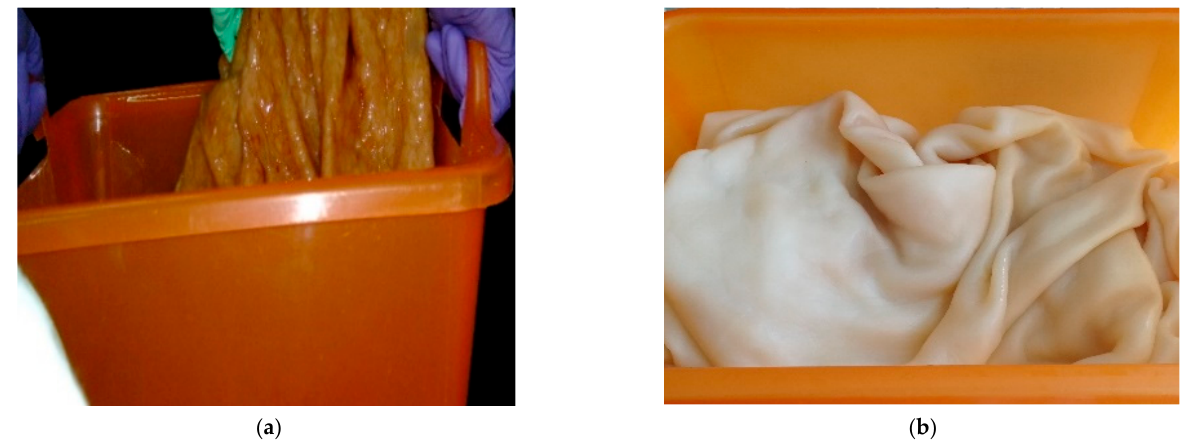
Figure 2. Washing of BNC sheets: ( а ) unwashed BNC sheet and ( b ) washed BNC sheet.